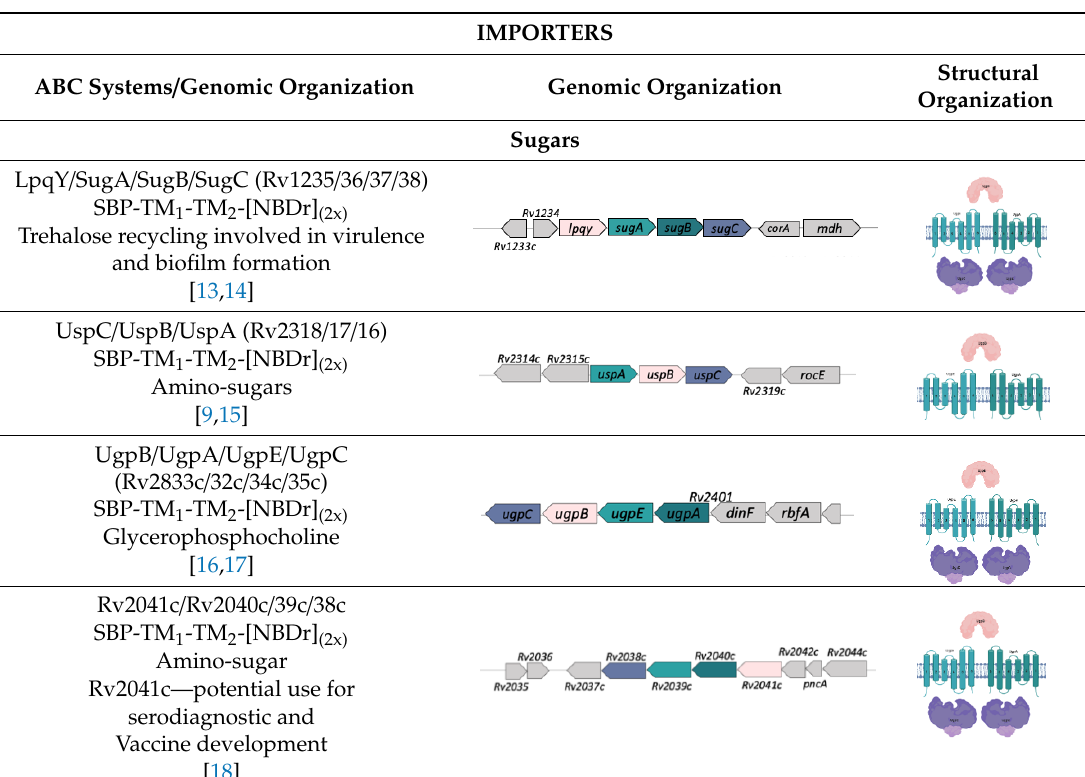
Table 1. Genomic context and structural organization of the ATP-Binding Cassette (ABC) importers in Mycobacterium tuberculosis . Importers are presented in seven groups organized by putative function. Genes that belong to the genomic context are shown as arrows. The number of helices and structural organization predicted with TOPCONS [12] are shown in the structural organization column. Substrate-binding proteins are represented in pale pink; transmembrane domains in light and dark green; nucleotide-binding domains in purple; and the regulatory domain, when present, in pale purple. SID: siderophore interaction domain.